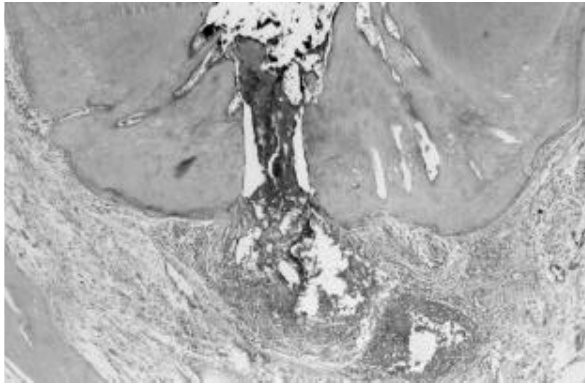
FIGURE 1- Treatment in one visit – Chronic inflammatory reaction in the periodontal ligament (H.E. X100) (Holland et al . 62 ).